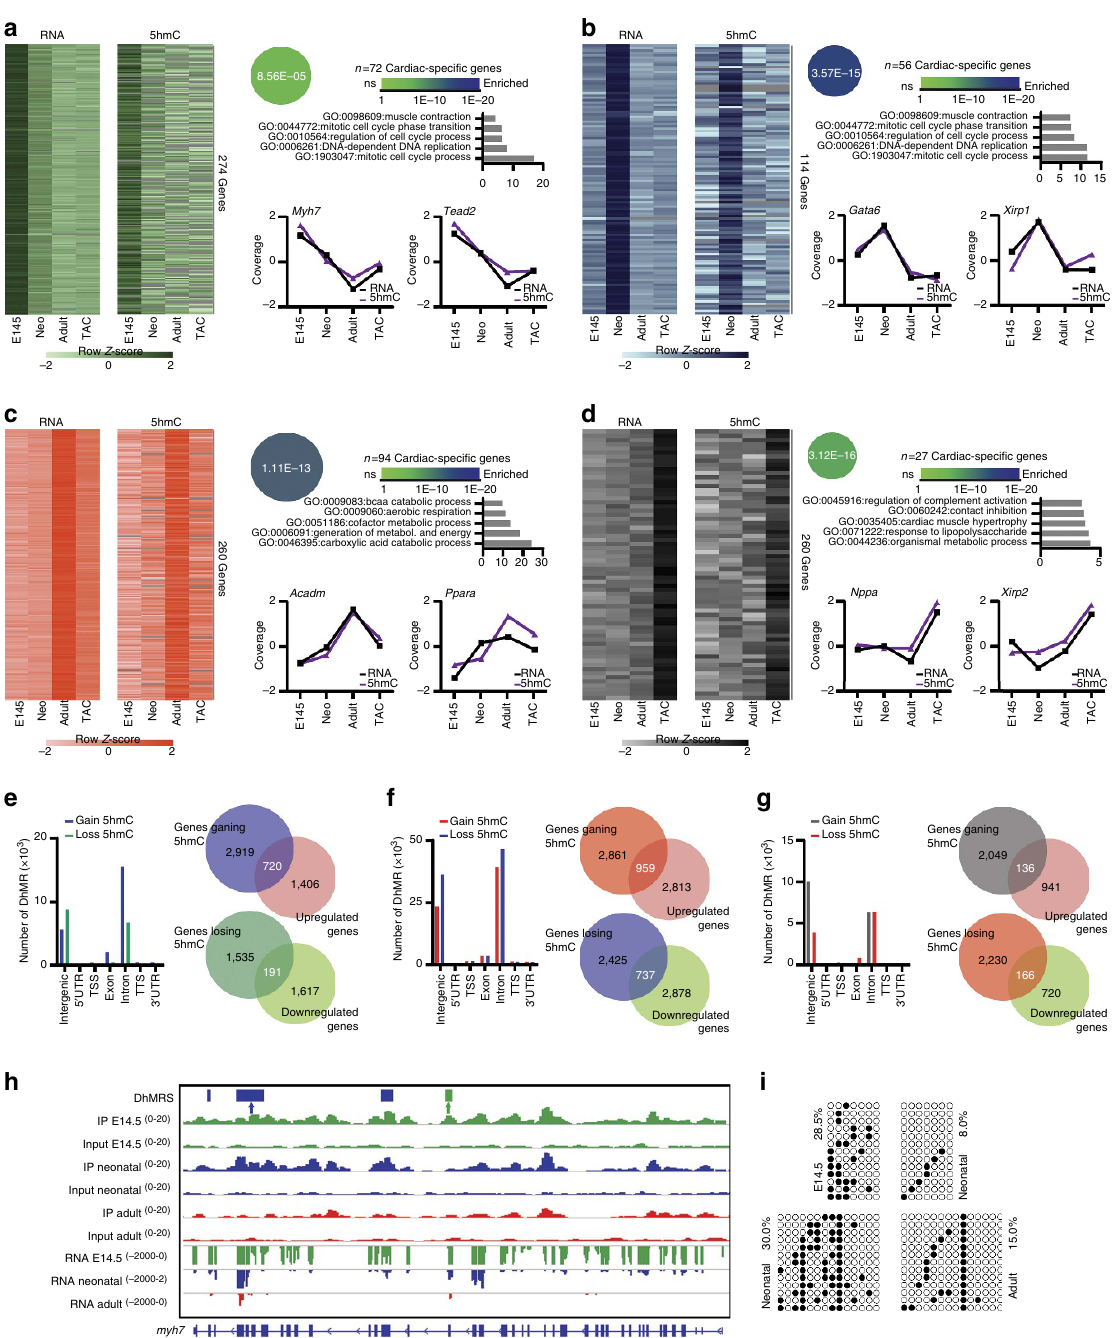
Figure 4 | Dynamic and highly correlated 5-hmC and gene expression patterns during differentiation. ( a – d ) Heat map of log 2 -transformed 5-hmC enrichment values and gene expression values for the embryonic ( a ), neonatal ( b ), adult ( c ) and hypertrophic ( d ) clusters. Beside each heat map are: enrichment of genes within the cardiovascular expression set of the Mouse Genome Informatics (MGI) database (www.inforamatics.jax.org), calculated with Fisher’s exact test, enriched GO terms and example genes. 5-hmC and gene expression are given as median-normalized values. ( e – g ) Association of all identified DhMRs within different genomic elements in the embryonic-to-neonatal ( e ), neonatal-to-adult ( f ) and adult-to-TAC ( g ) transitions (left). Venn diagrams show the overlaps between the number of genes undergoing solely 5-hmC acquisition on the GB (exons plus introns) and upregulation of gene expression (assessed by RNA-seq) (right top), and the number of genes undergoing solely 5-hmC loss on the GB and downregulation of gene expression (right bottom). ( h ) IGV profile of 5-hmC MeDIP-seq and RNA-seq profiles of the cardiac-specific gene Myh7 . DhMRs identified with MeDIPS are indicated by boxes above the tracks (green, DhMRs in the embryonic-to-neonatal transition; blue, DhMRs in the neonatal-to-adult transition). Scales for each track are shown to the left. Exact locations of primers used to validate DhMRs are shown above the IGV profile (green arrow, embryonic-to-neonatal transition; blue arrow, neonatal-to-adult transition). Primer sequences are listed in Supplementary Table 2. ( i ) Validation of 5-hmC by single-base resolution analysis (TAB sequencing) in embryonic-to-neonatal (top) and neonatal-to- adult (bottom) transitions. Black circles indicate hydroxymethylated CpGs; open circles indicate unmethylated